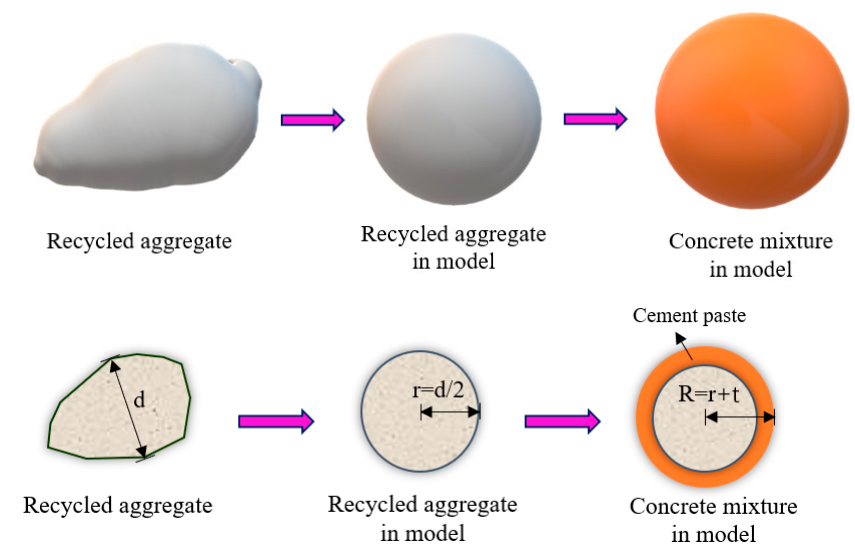
Figure 15. Ideal sphere model of low-grade RA.